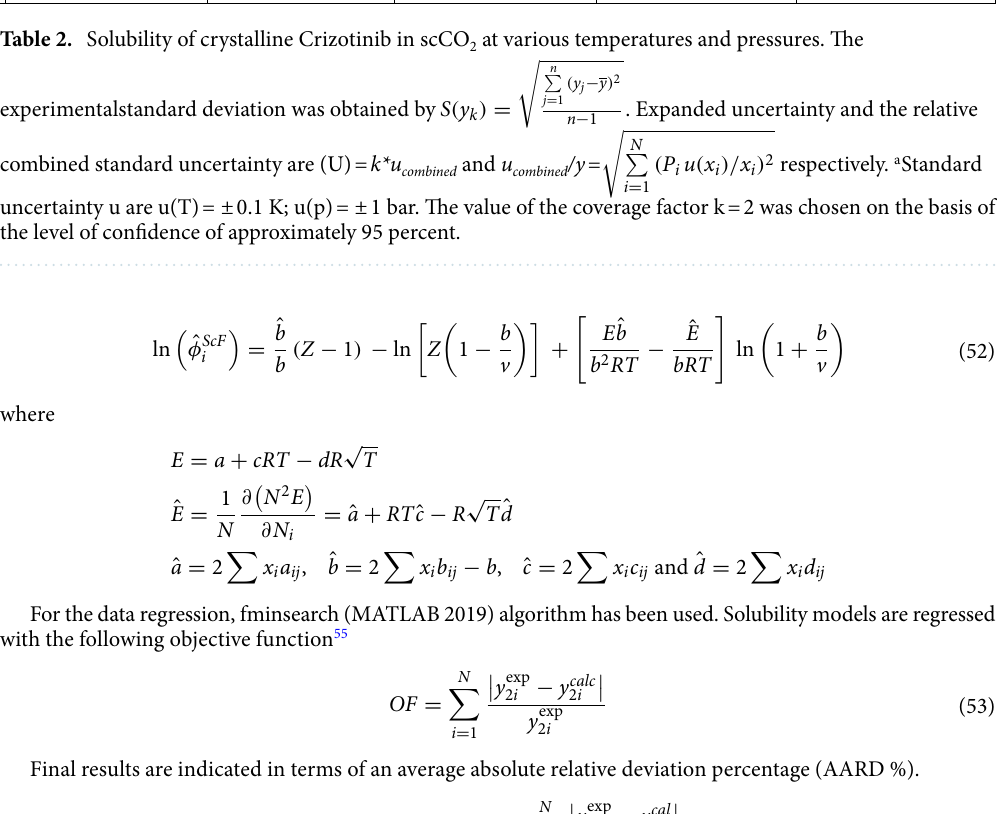
Final results are indicated in terms of an average absolute relative deviation percentage (AARD %).